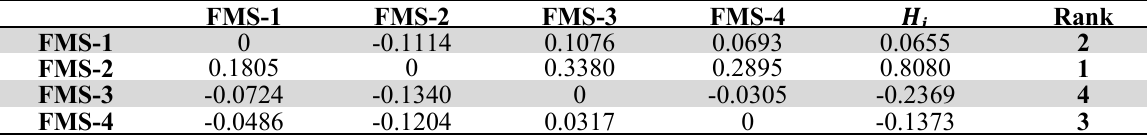
Relative assessment matrix and final assessment